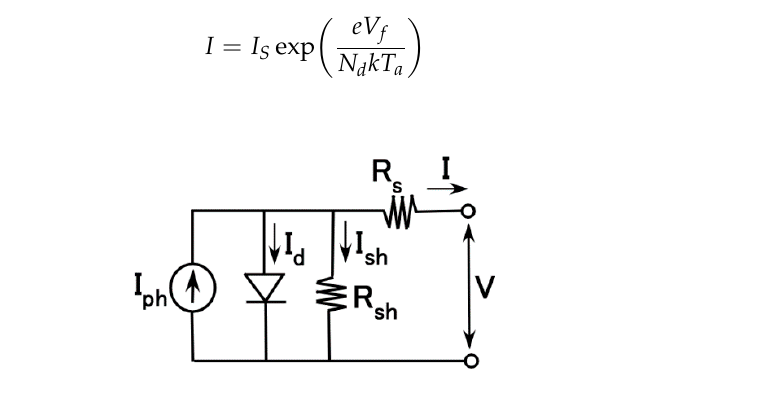
Figure 5. Equivalent electric circuit of MCF rubber solar cell.